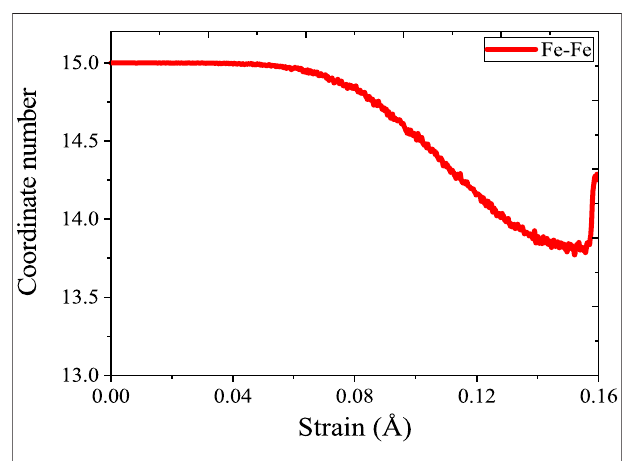
FIGURE 7 | Strain – coordination map of iron atoms in Fe structure.